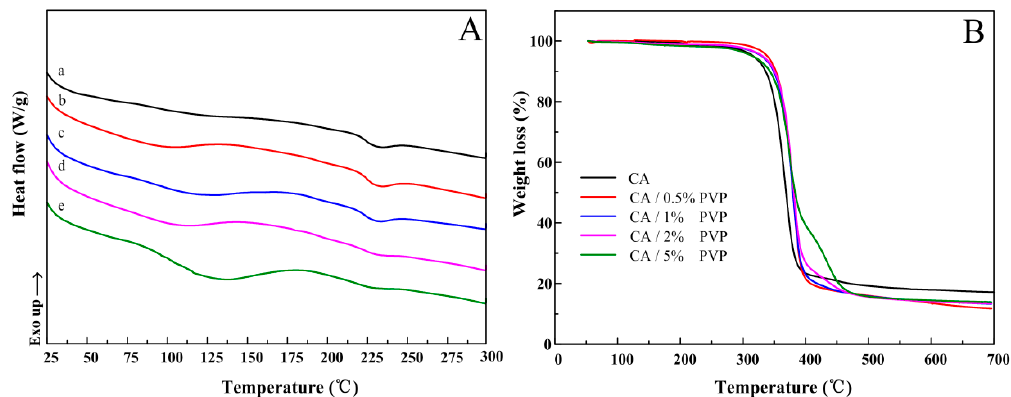
Figure 4. ( A ) DSC and ( B ) TGA curves of the CA/PVP hybrid nanofibers with varying PVP quantities: